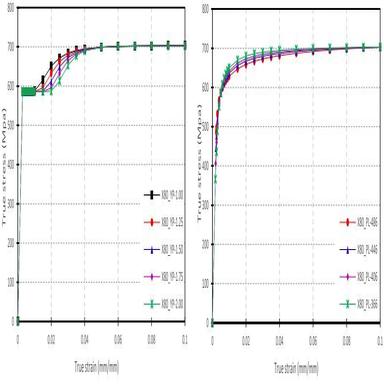
Idealized variations for stress–strain curves of X80-YPT and X80-RHT materials.